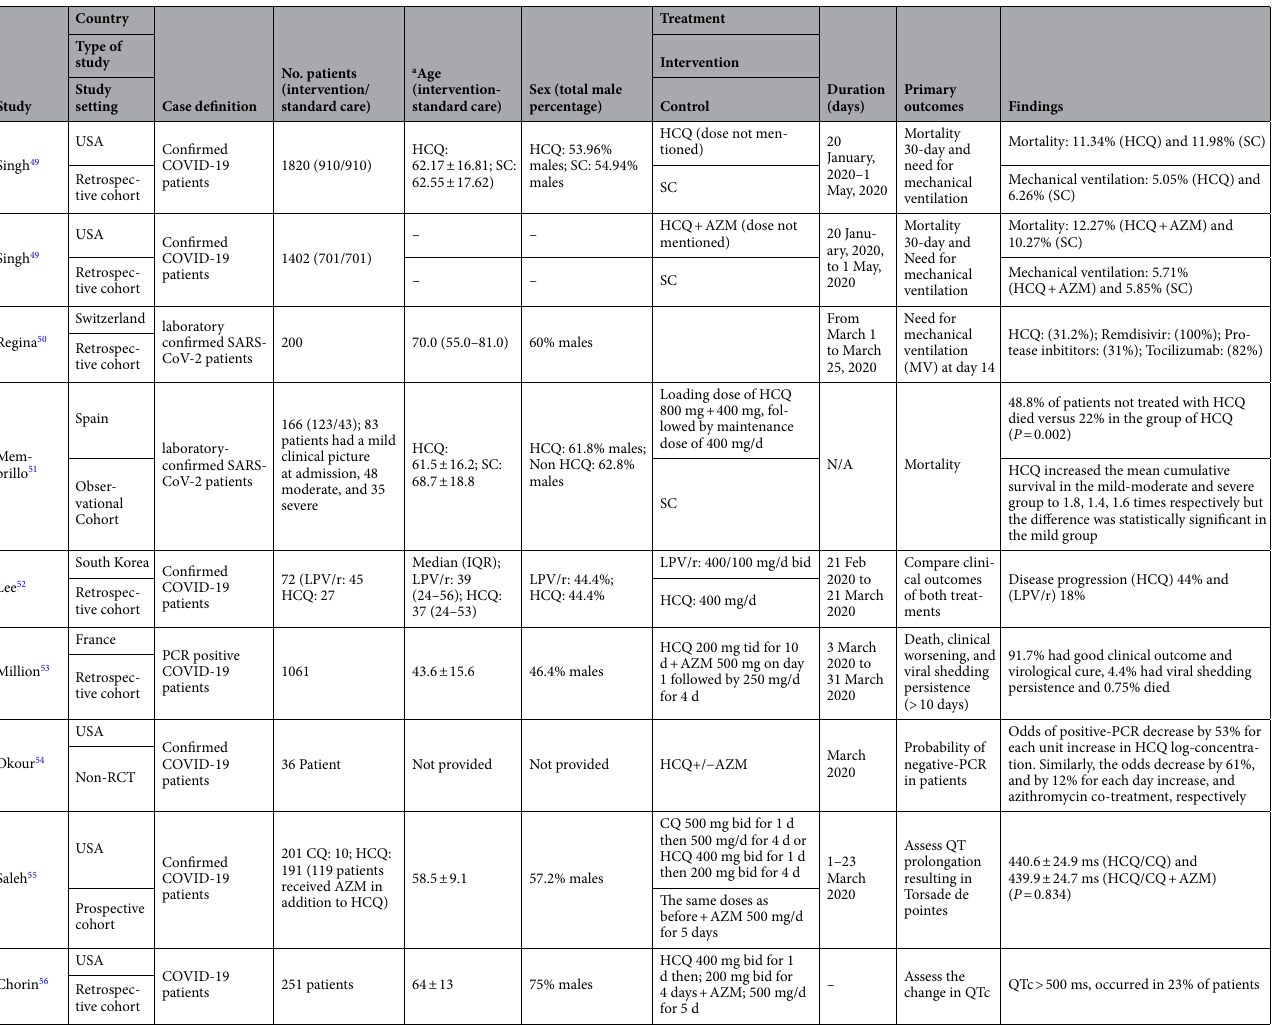
Table 1. All published studies that reported the effectiveness or safety of hydroxychloroquine, chloroquine, or azithromycin. aHR adjusted hazard ratio, ARDS acute respiratory distress syndrome; AZM azithromycin, CI confidence interval, CQ chloroquine, CT computed tomography, HCQ hydroxychloroquine, ICU intensive care unit, IQR interquartile range, LPV/r Lopinavir/ritonavir, ms milliseconds, N/A not applicable, PCR Polymerase chain reaction, QTc corrected QT interval, RCT randomized control trial, SC standard care. a Age was presented either as mean ± Standard deviation or median (Interquartile